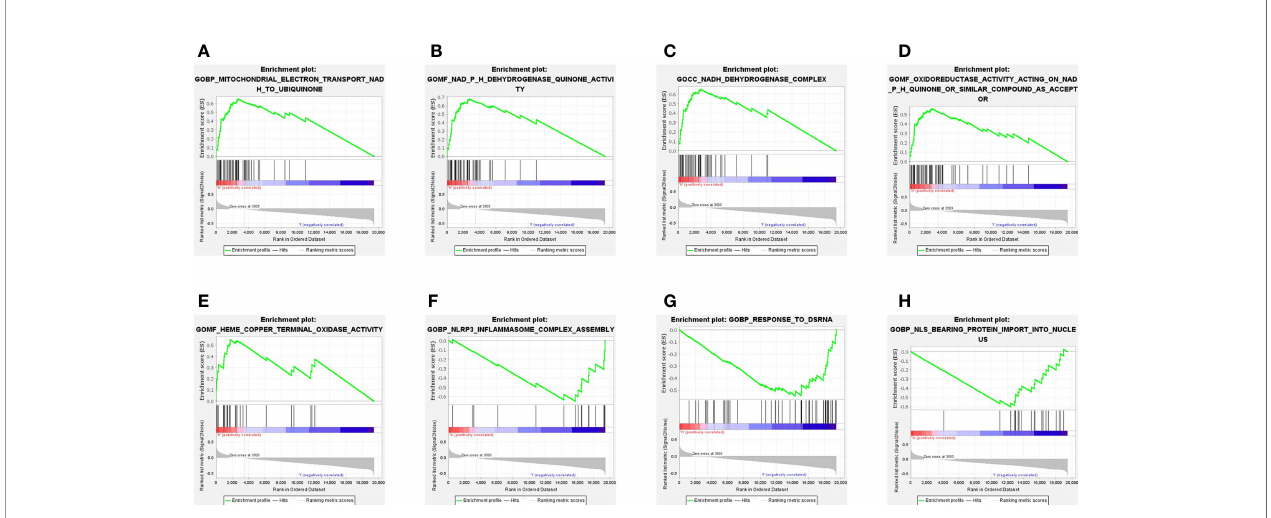
FIGURE 5 | Gene set enrichment analysis (GSEA) in the TCGA cohort. (A – E) Signaling pathways signi fi cantly enriched in HR group. (F – H) 3 non-ferroptosis-related pathways enriched in LR